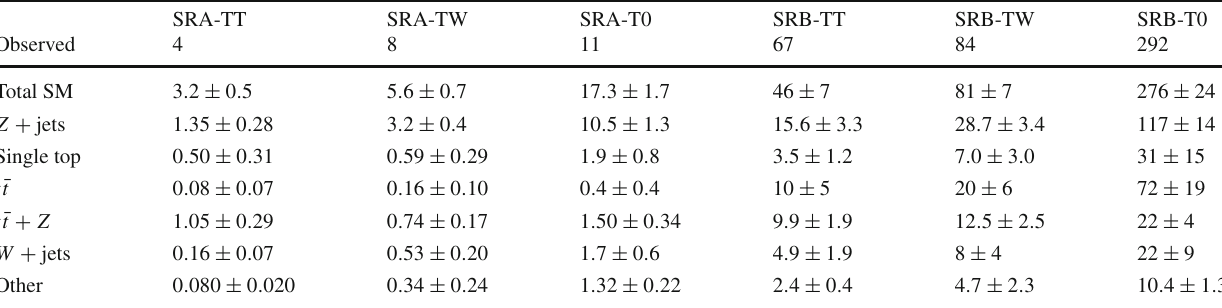
Table 11 Observed event yields in SRA and SRB compared with the expected SM background yields in each signal region after the SRA–B background-only fit. The uncertainties include MC statistical uncertainties, detector-related systematic uncertainties, and theoretical uncertainties